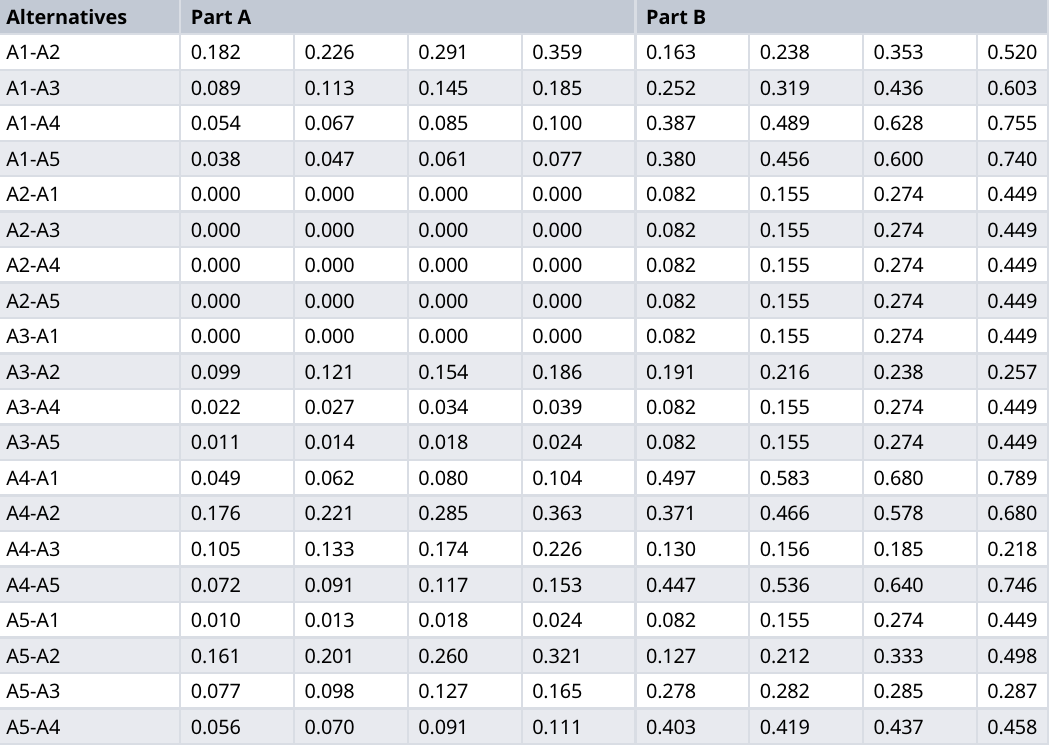
Table 10. Z-number based weighted preference function.